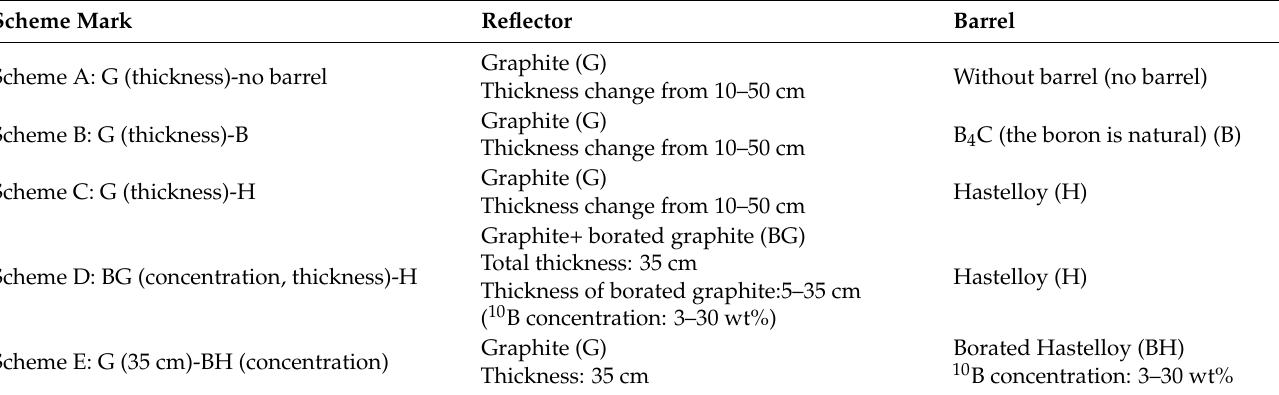
Table 2. Design schemes with different reflector thickness and shielding materials (G stands for graphite, B stands for boron carbide or borated material, H stands for Hastelloy, ‘-’ substitutes separatrix between reflector and